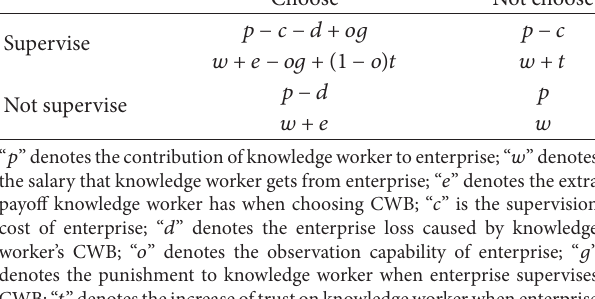
Figure 1: Theoretical model of knowledge workers’ CWB.